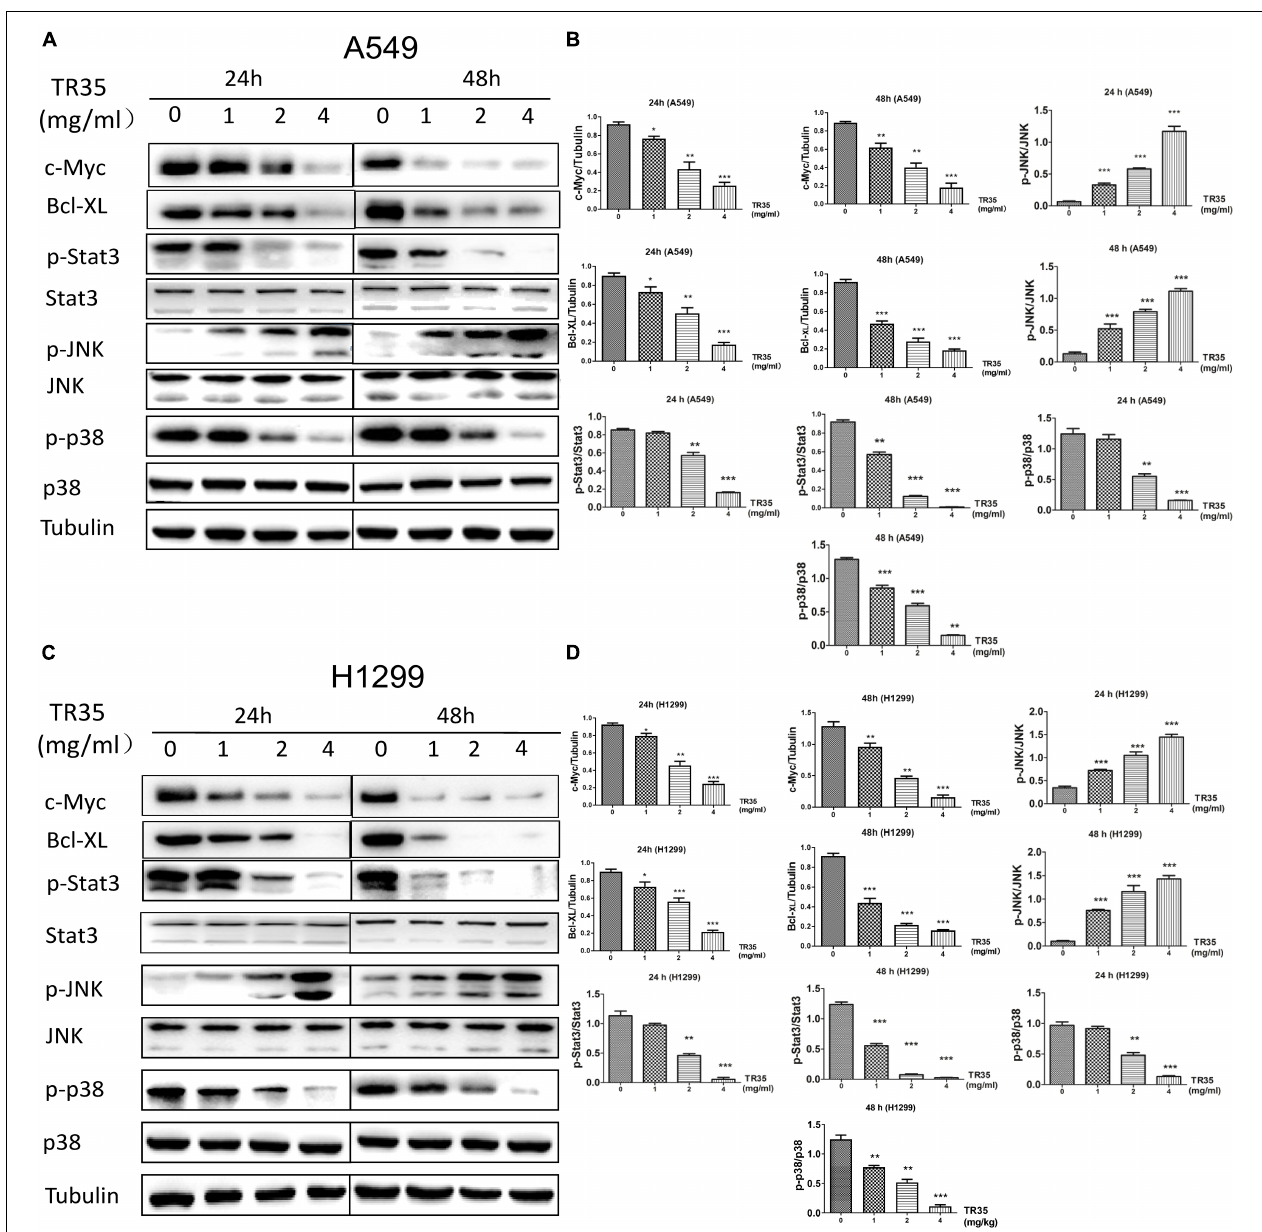
FIGURE 3 | Activation of JNK and reduction of p38 and STAT3 activities by TR35 treatment in H1299 and A549 cells. (A,C) A549 and H1299 cells were treated with TR35 (0–4 mg/mL) for 24 and 48 h. STAT3, p38, and JNK steady state and phosphorylated levels were analyzed by western blotting. Tubulin was used as loading controls. (B,D) Quantification of the band density was analyzed by ImageJ software. Data are presented as the mean ± SEM, n = 3 (* p < 0.05, ** p < 0.01, *** p < 0.001 vs. CON).